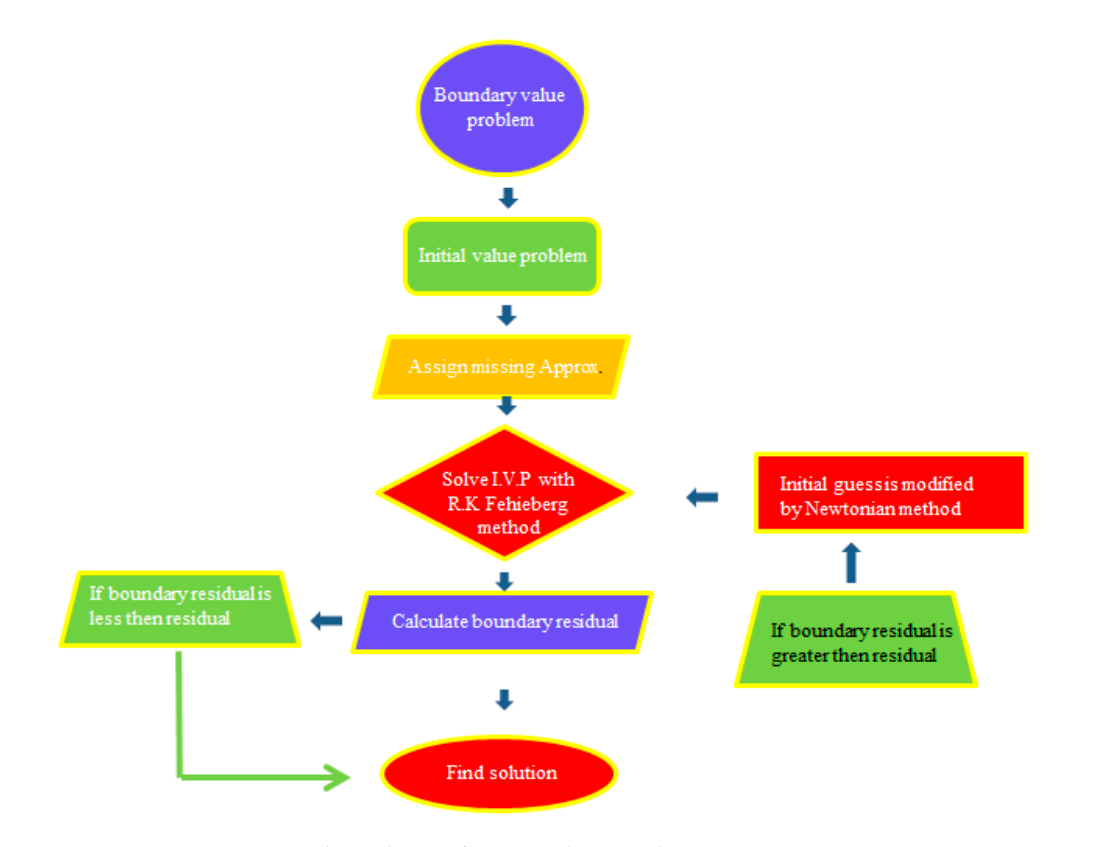
Figure 2. Flow scheme of numerical approach.